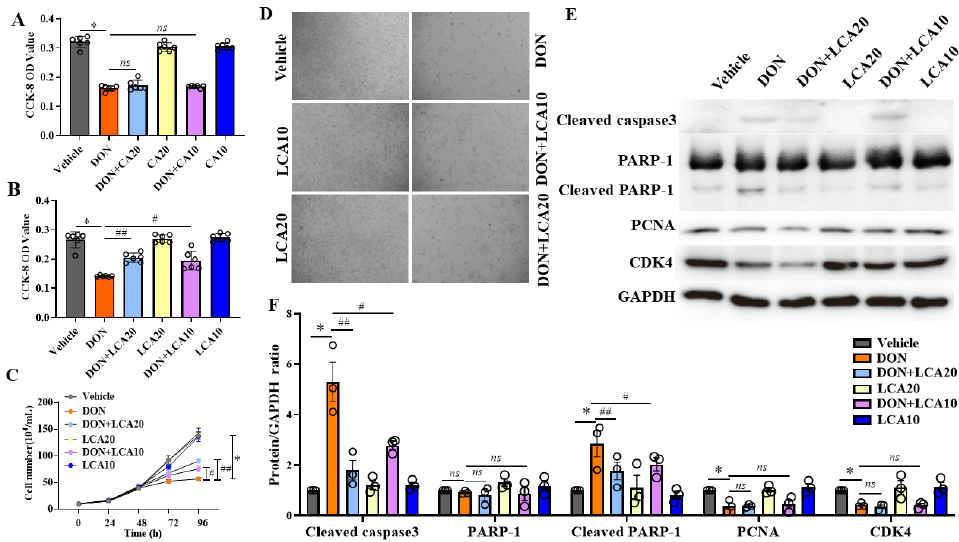
Figure 1. LCA pretreatment alleviates the DON-induced IPI-2I cell death. With CA ( A ) or LCA ( B ), pretreatment in IPI-2I cells for 24 h, DON was added for another 48 h to process CCK-8 analysis. ( C ) Cell number measurement at different time points (0, 24, 48, 72, 96 h) with indicated treatments. ( D ) LCA pretreatment for 24 h, followed by DON for another 48 h, and cell morphology was captured at 40 × magnification. ( E ) Western blotting analyses of cleaved caspase 3, PARP-1, PCNA, CDK4, and GAPDH (used as an internal reference). ( F ) The relative expression levels of cleaved caspase 3, PARP-1, cleaved PARP-1, PCNA, and CDK4 were determined by GAPDH standardization. Results are mean ± SD. n = 3. * represents DON group vs. vehicle group p < 0.05, # represents DON + LCA10 group vs. DON group p < 0.05. ## represents DON + LCA20 group vs. DON group p < 0.05. ns represents no significant difference between the two groups.